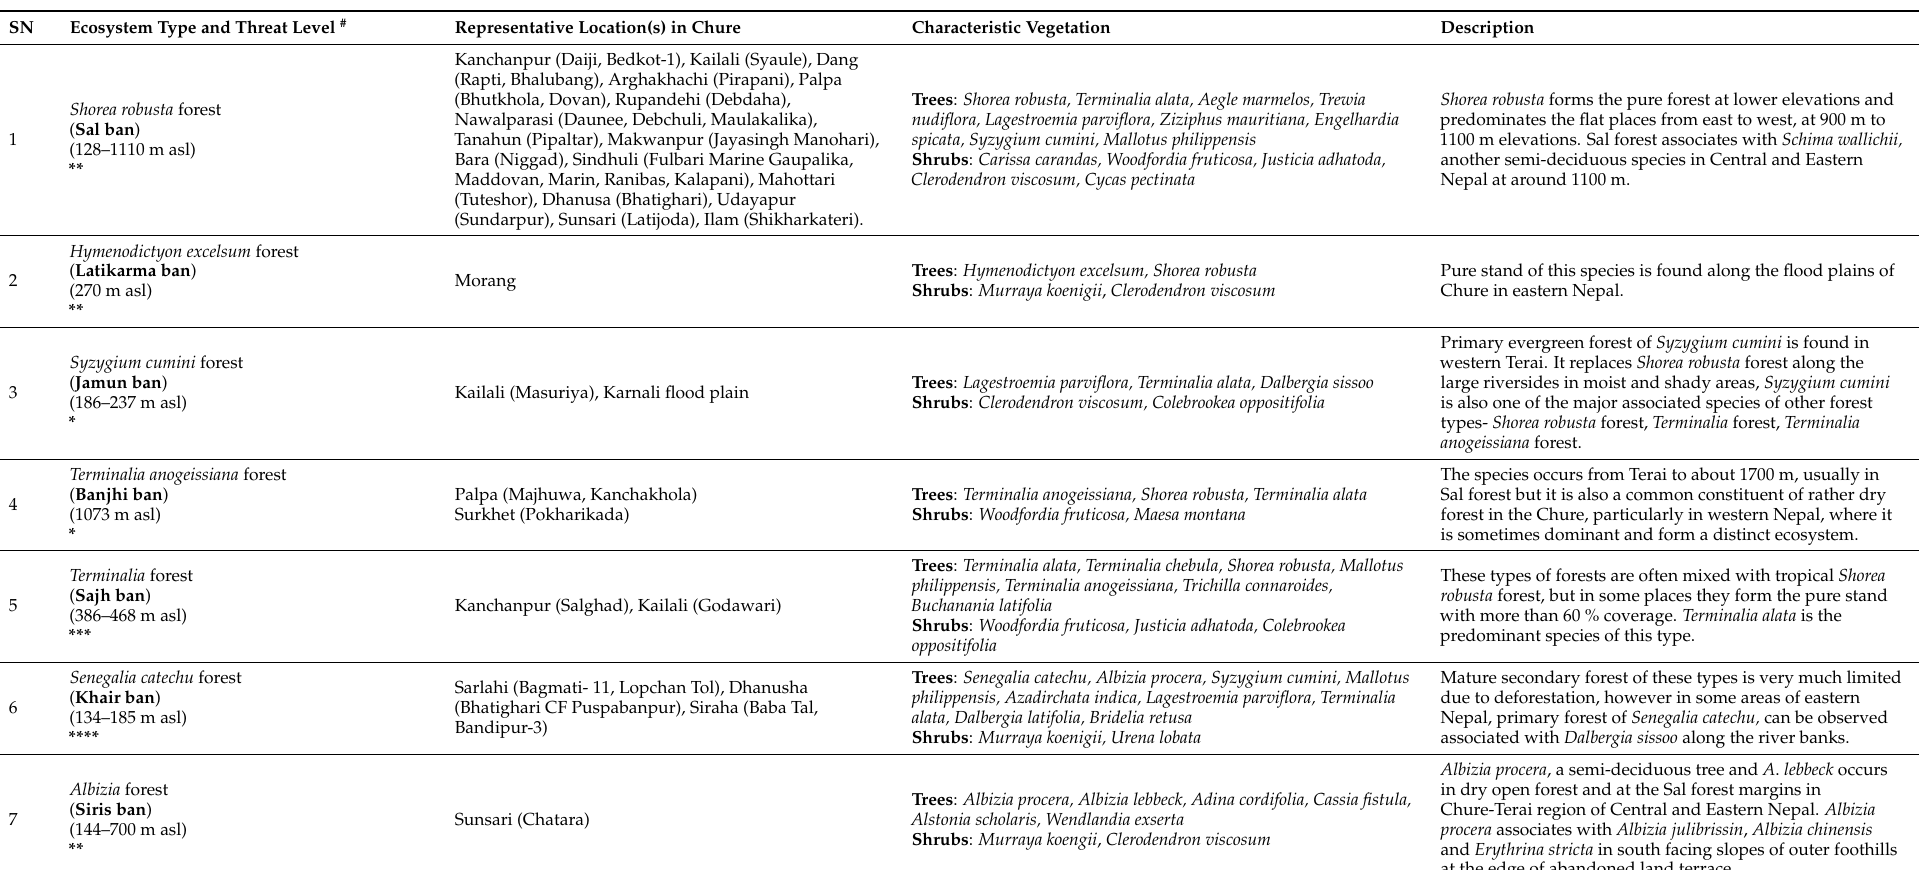
Table 1. Forest ecosystem types with their characteristic vegetation and general description in Chure (see Table S1 for location of the ecosystem types and GPS